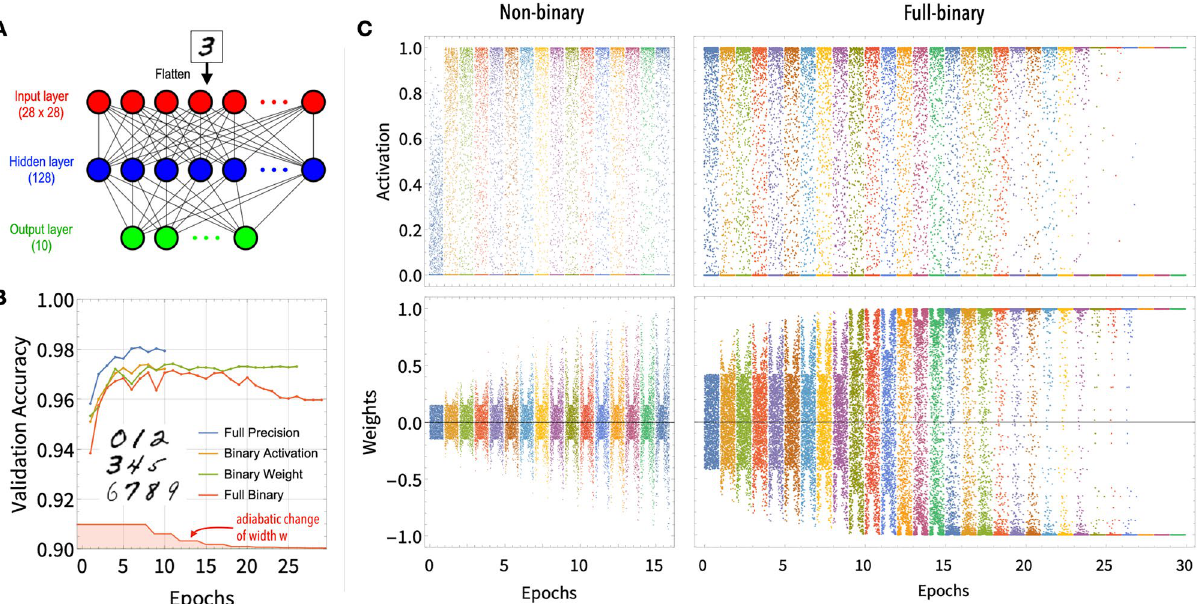
Figure 1. ( A ) The fully-connected neural network with one hidden layer, used for the recognition of hand- written number images. ( B ) The comparison of validating accuracies (using the present width) as function of epochs realized by the non-binary , binary-activation , binary-weight , and full-binary networks for the numbered image. The adiabatic change of width w as function of epochs for the full-binary case is shown in the bottom of the panel. The sharp dips in the full-binary training curve are due to the sudden change in w . ( C ) The distribution of activation outputs (top) and weights values (bottom) for successive epochs (each color